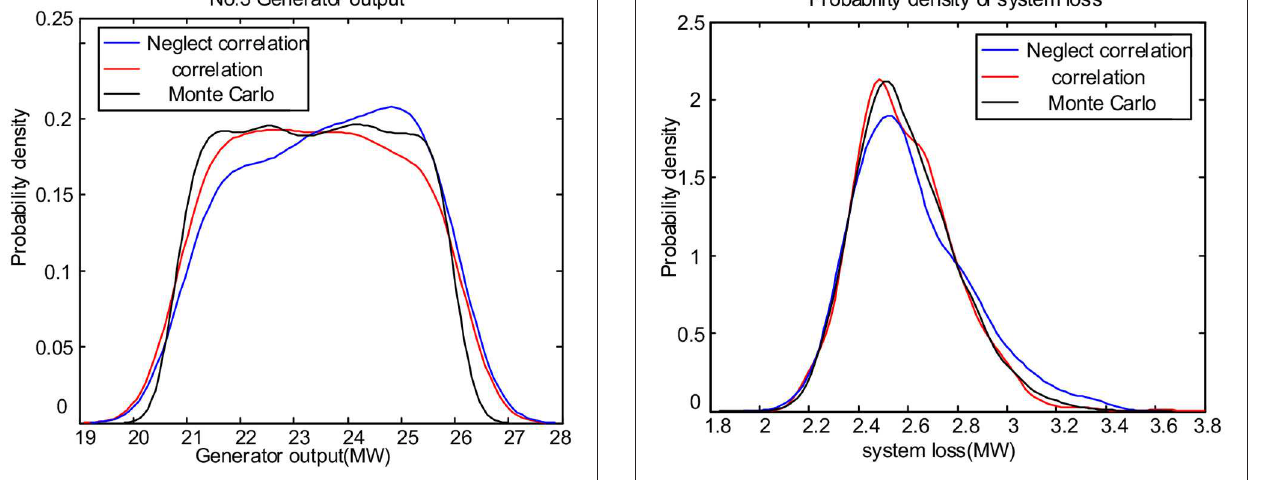
FIGURE 10 | Probability density of system loss.